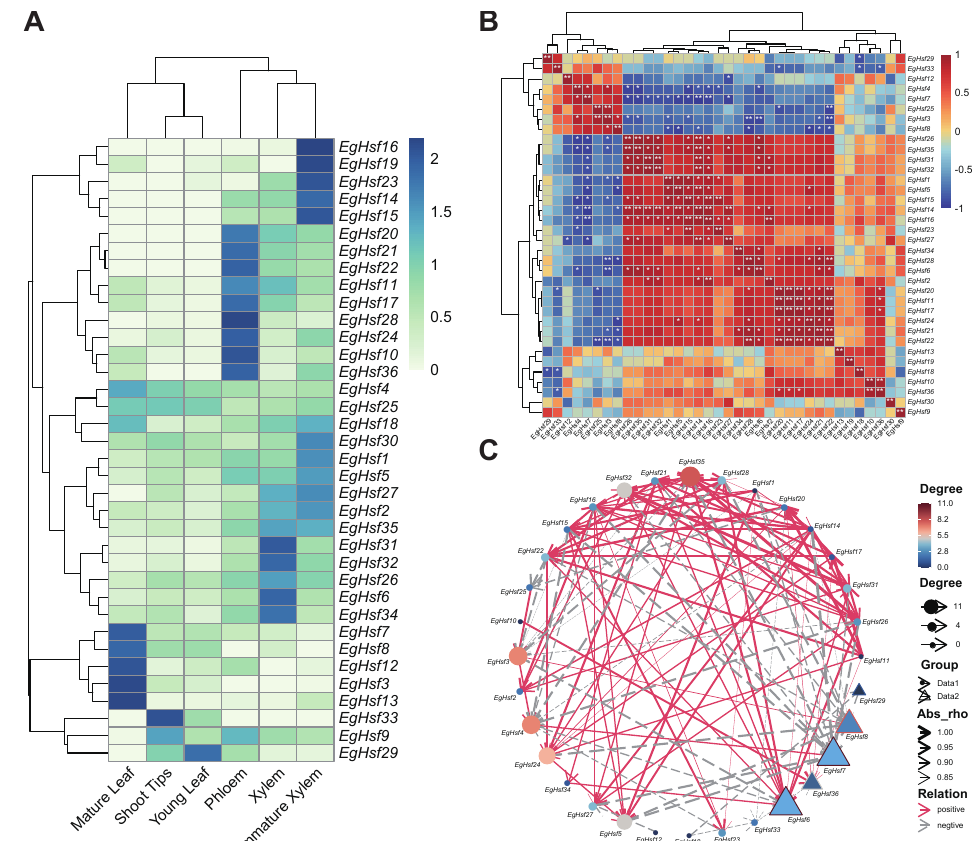
Figure 8. Analysis of the expression patterns and networking of 36 EgHsf genes in Eucalyptus. ( A ) Gene expression patterns in six tissues, including xylem, immature xylem, phloem, shoot tips, mature leaf and young leaf. The color in the upper right corner represents the expression level: red signifies a high expression level, while blue signifies a low expression level. ( B ) Correlation of gene expression. The darker the color in the figure, the stronger the correlation. Red denotes a positive correlation, and blue represents a negative correlation. The asterisk records the significance of the correlation value. The more asterisks, the greater the significance. The picture is diagonally symmetric for a single table, and the diagonal number is always 1 (the correlation between the same genes was 100%, * represents < 0.05, and ** represents < 0.01). ( C ) Gene network. Red line represents a positive connection with surrounding genes: the denser and thicker the line, the higher the significance. The grey line represents the negative correlation effect, and the color from blue to red shows the strength of the